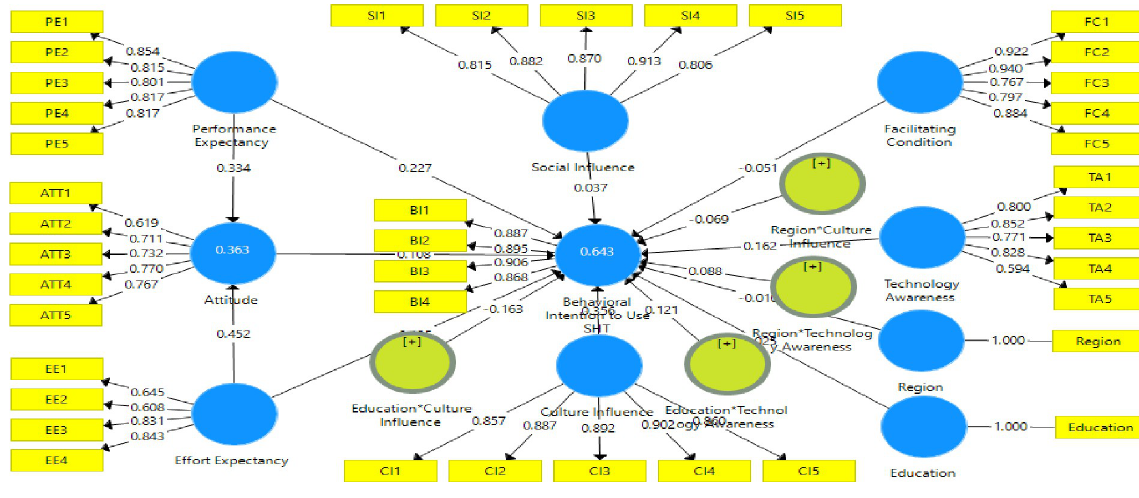
Fig 5. Structural model